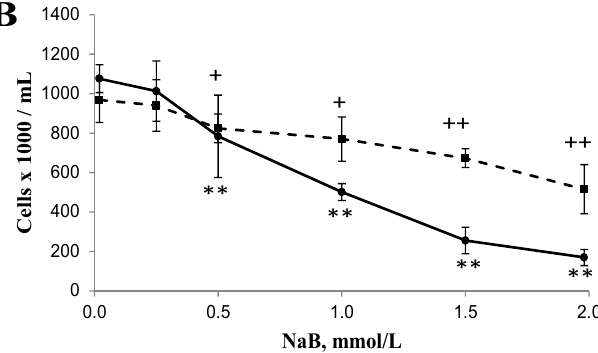
Figure 1. Effect of sodium butyrate (NaB) treatment for ( A ) 24 h and ( B ) 48 h on the growth of cancerous HCT116 (solid lines) and non ‐ cancerous NCM460 (dashed lines) colon cells. Values are means ± SD, n = 5 to 6. There was a significant interaction between cell type and concentration at 24 h ( p = 0.01) and at 48 h ( p < 0.0001) by two ‐ way ANOVA. * Different from HCT116 control (0 mmol/L NaB); * p < 0.05, ** p < 0.0001. + Different from NCM460 control (0 mmol/L NaB); + p < 0.05, ++ p < 0.0001.